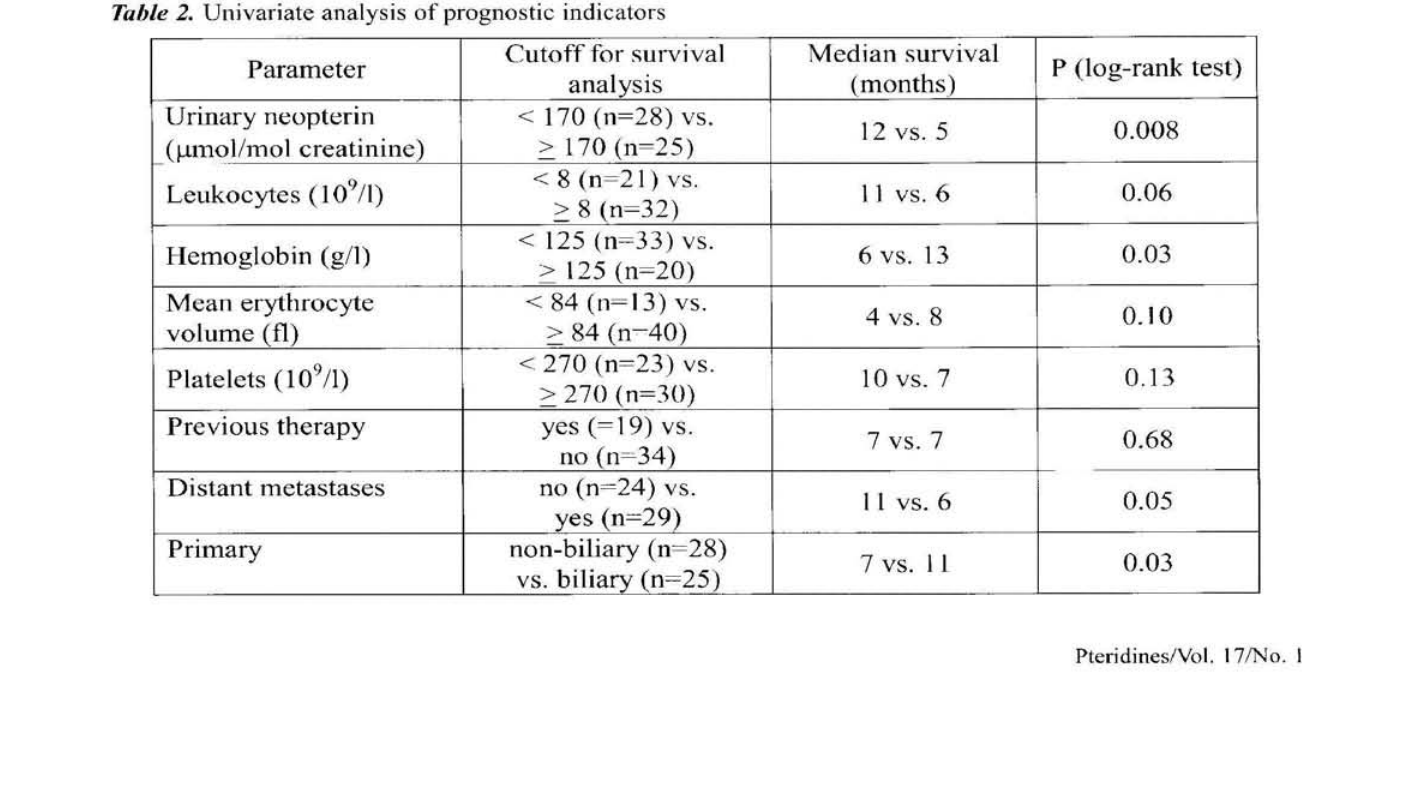
Cutoff for survival analysis